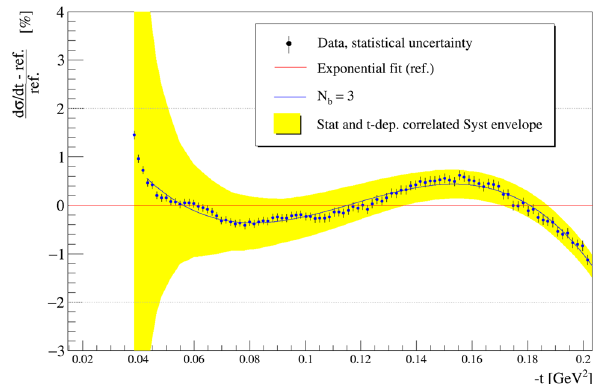
Fig. 10 The non-exponential part of the data. The statistical and | t | - dependent correlated systematic uncertainty envelope is shown as a yellow band, while the data points show the statistical uncertainty